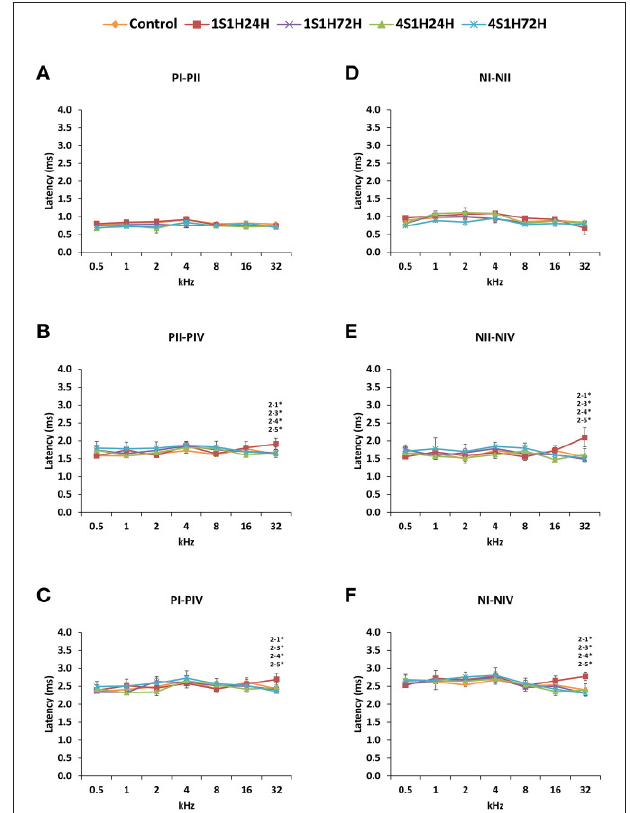
FIGURE 5 | Line graphs showing the positives and negatives interpeak intervals (ms) of waves I, II, and IV plotted as a function of the frequencies in control and experimental animals. Whereas no differences were found between waves I and II (A,D) , significantly longer positives and negatives interpeak intervals at 32kHz were observed between waves II and IV (B,E) and between waves I and IV (C,F) by 24h after the first session. These differences were no longer present by the fourth session of noise overstimulation. Stimulus intensity = 80dB SPL. (1) Control; (2) 1S1H24H; (3) 1S1H72H; (4) 4S1H24H; (5) 4S1H72H. * p < 0.05